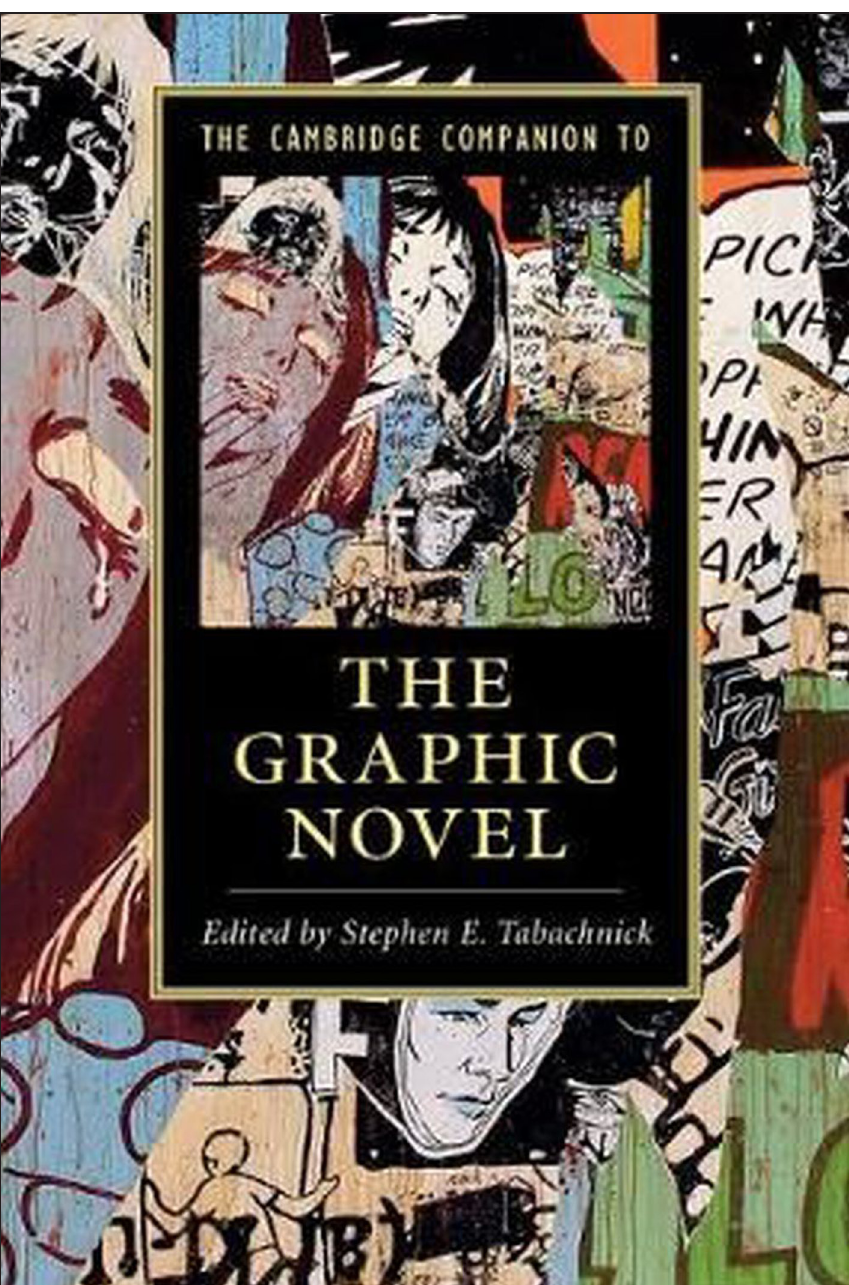
Figure 1: Cover of The Cambridge Companion to the Graphic Novel . Stephen Tabachnick (ed.), Cambridge University Press, 2017. [Small image file as made available by the publishers at